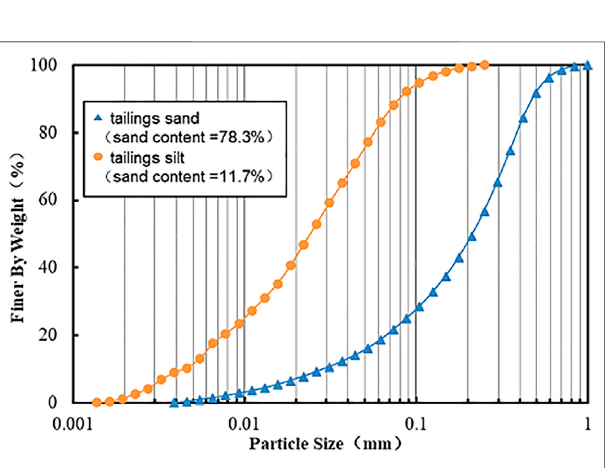
FIGURE 1 | Distribution of the main seismic belt of China and location of the Xiaodae tailing pond.